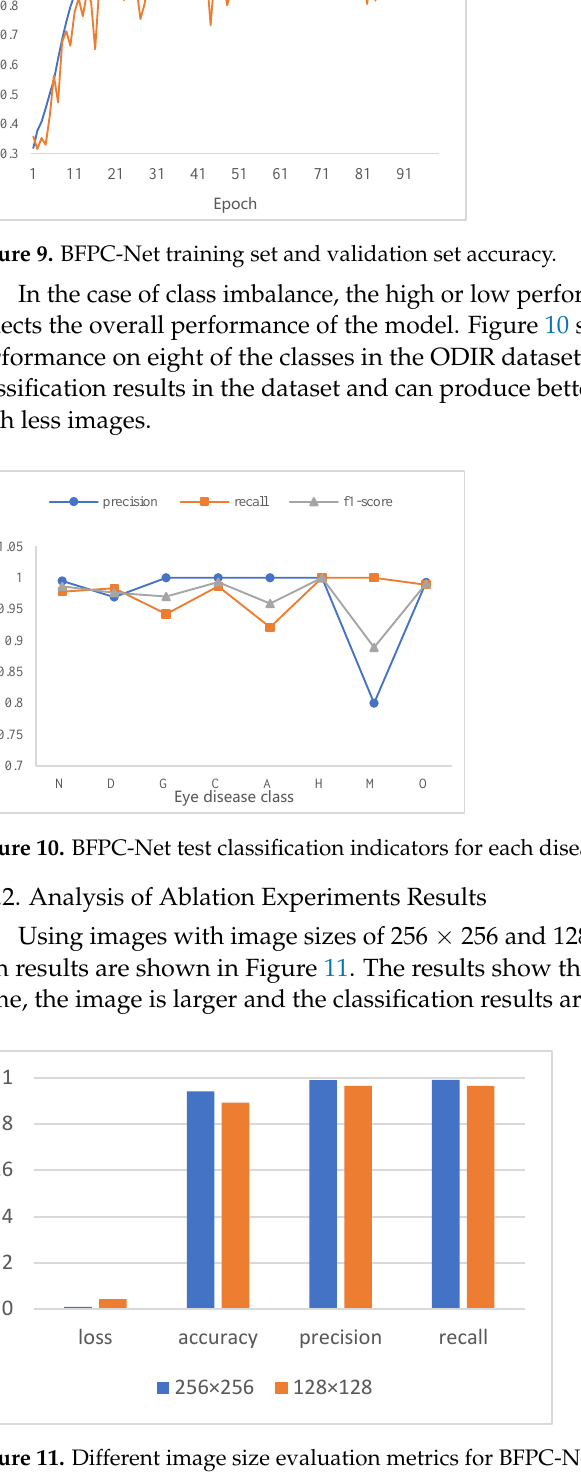
Figure 9. BFPC-Net training set and validation set accuracy.